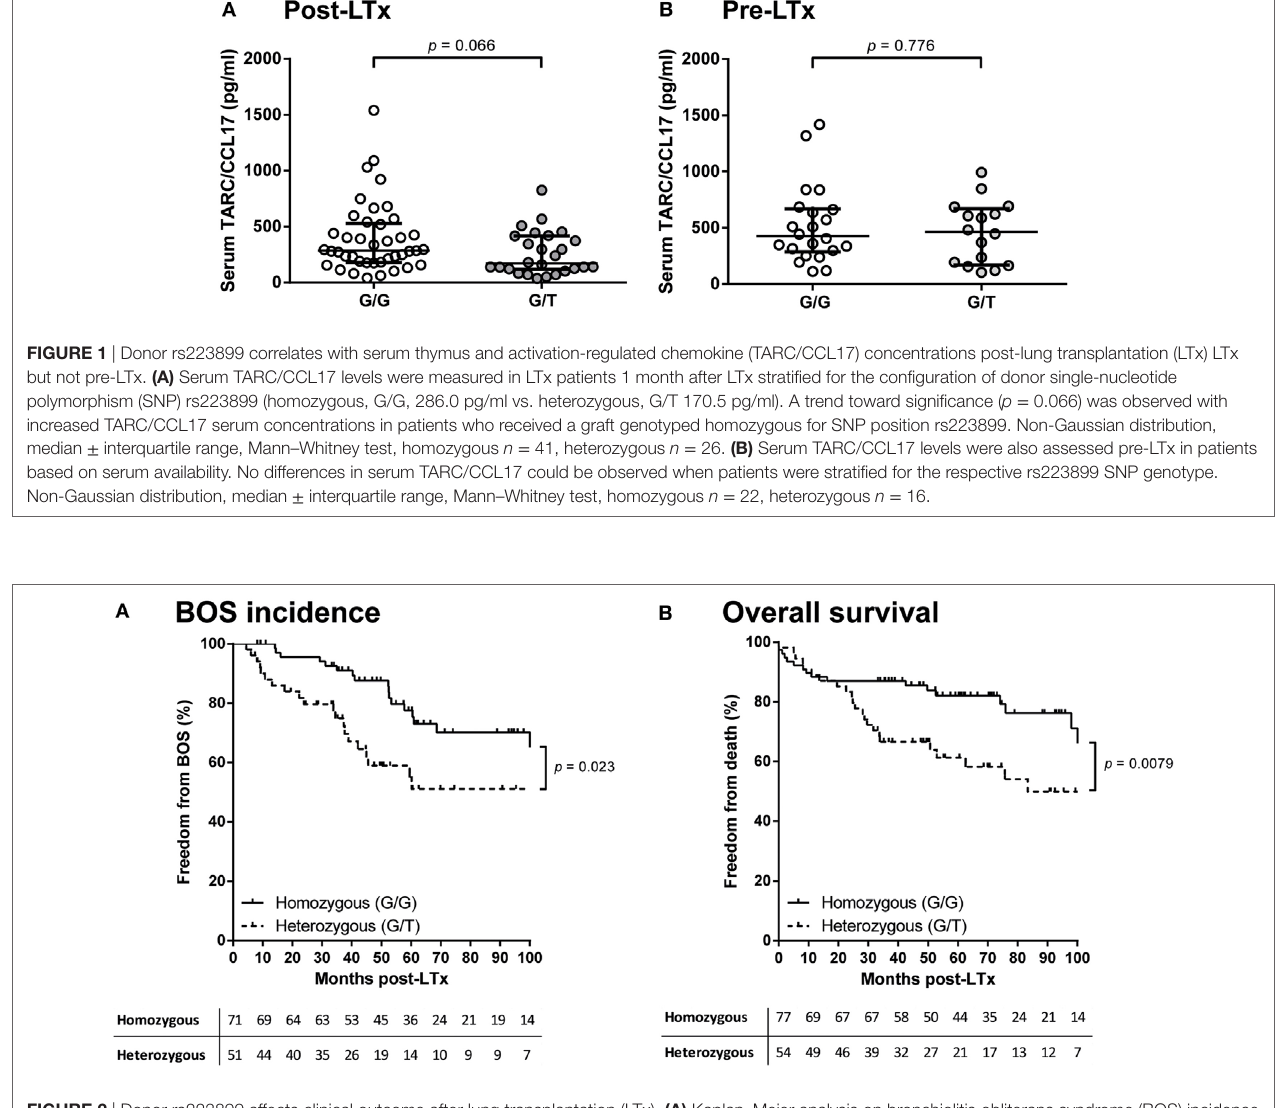
FigUre 2 | Donor rs223899 affects clinical outcome after lung transplantation (LTx). (a) Kaplan–Meier analysis on bronchiolitis obliterans syndrome (BOS) incidence after LTx. Patients were stratified according to the single-nucleotide polymorphism (SNP) configuration of rs223899 in the received allograft. Patients who received a graft genotyped as heterozygous (G/T) for this specific SNP have a lower BOS-free survival rate measured over the first 100 months after transplantation ( p = 0.023). Lower table represents numbers at risk. All 131 patients for which the imputed donor SNP passed quality control (QC) were included. (b) Kaplan–Meier analysis on survival after LTx. Patients were stratified as mentioned earlier. Additional to an increase of chronic rejection after LTx, stratification of LTx patients for receiving a grafted organ genotyped heterozygous (G/T) at SNP position rs223899 resulted in a lower survival rate post-LTx ( p = 0.0079). Lower table represents numbers at risk. Patients who had deceased within the first 4 months after transplantation or from whom SNP analysis did not pass QC were excluded, resulting in the inclusion of 122 patients. Log-rank test used in both